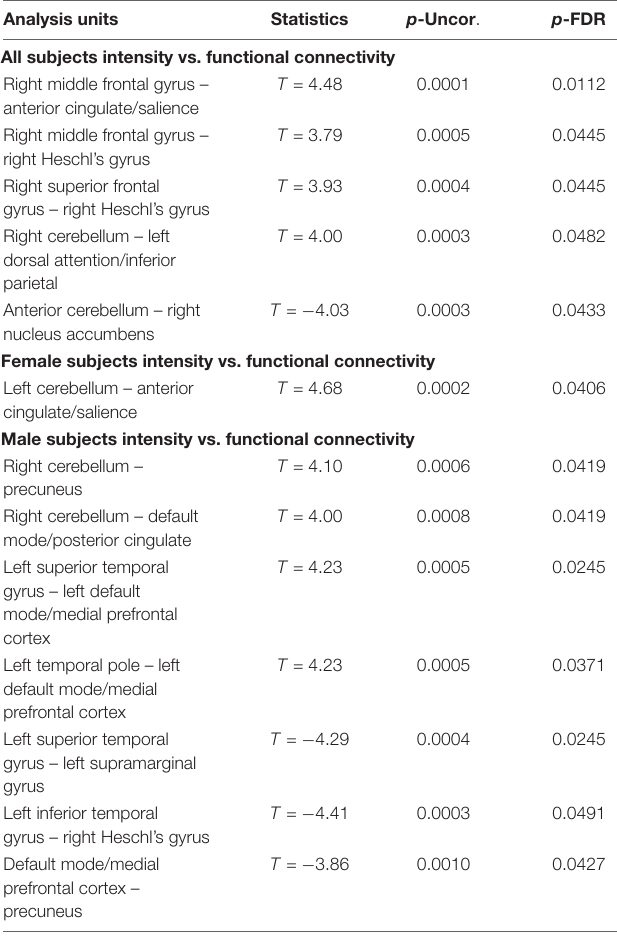
TABLE 3 | Significant correlations between the change in functional connectivity (OM vs. neutral condition) and the subjective feeling of intensity during the OM practice showing the uncorrected p value (p-Uncor.) and False Discovery Rate corrected p -value